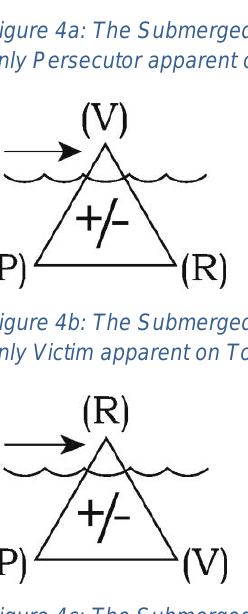
Figure 4c: The Submerged Compassion Triangle - only Rescuer apparent on